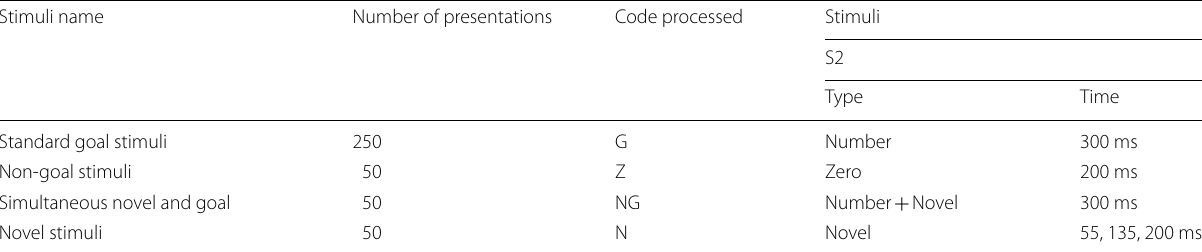
Table 1 Stimuli combinations for the simultaneous EEG/fMRI experiment